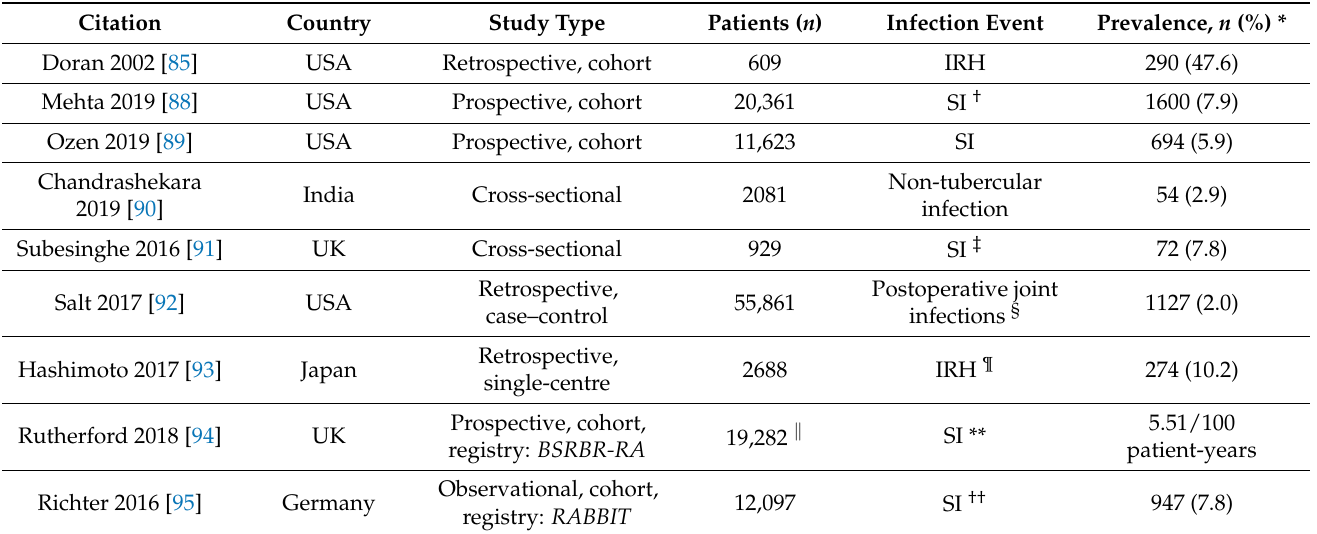
Table 3. Prevalence of infections in patients with rheumatoid